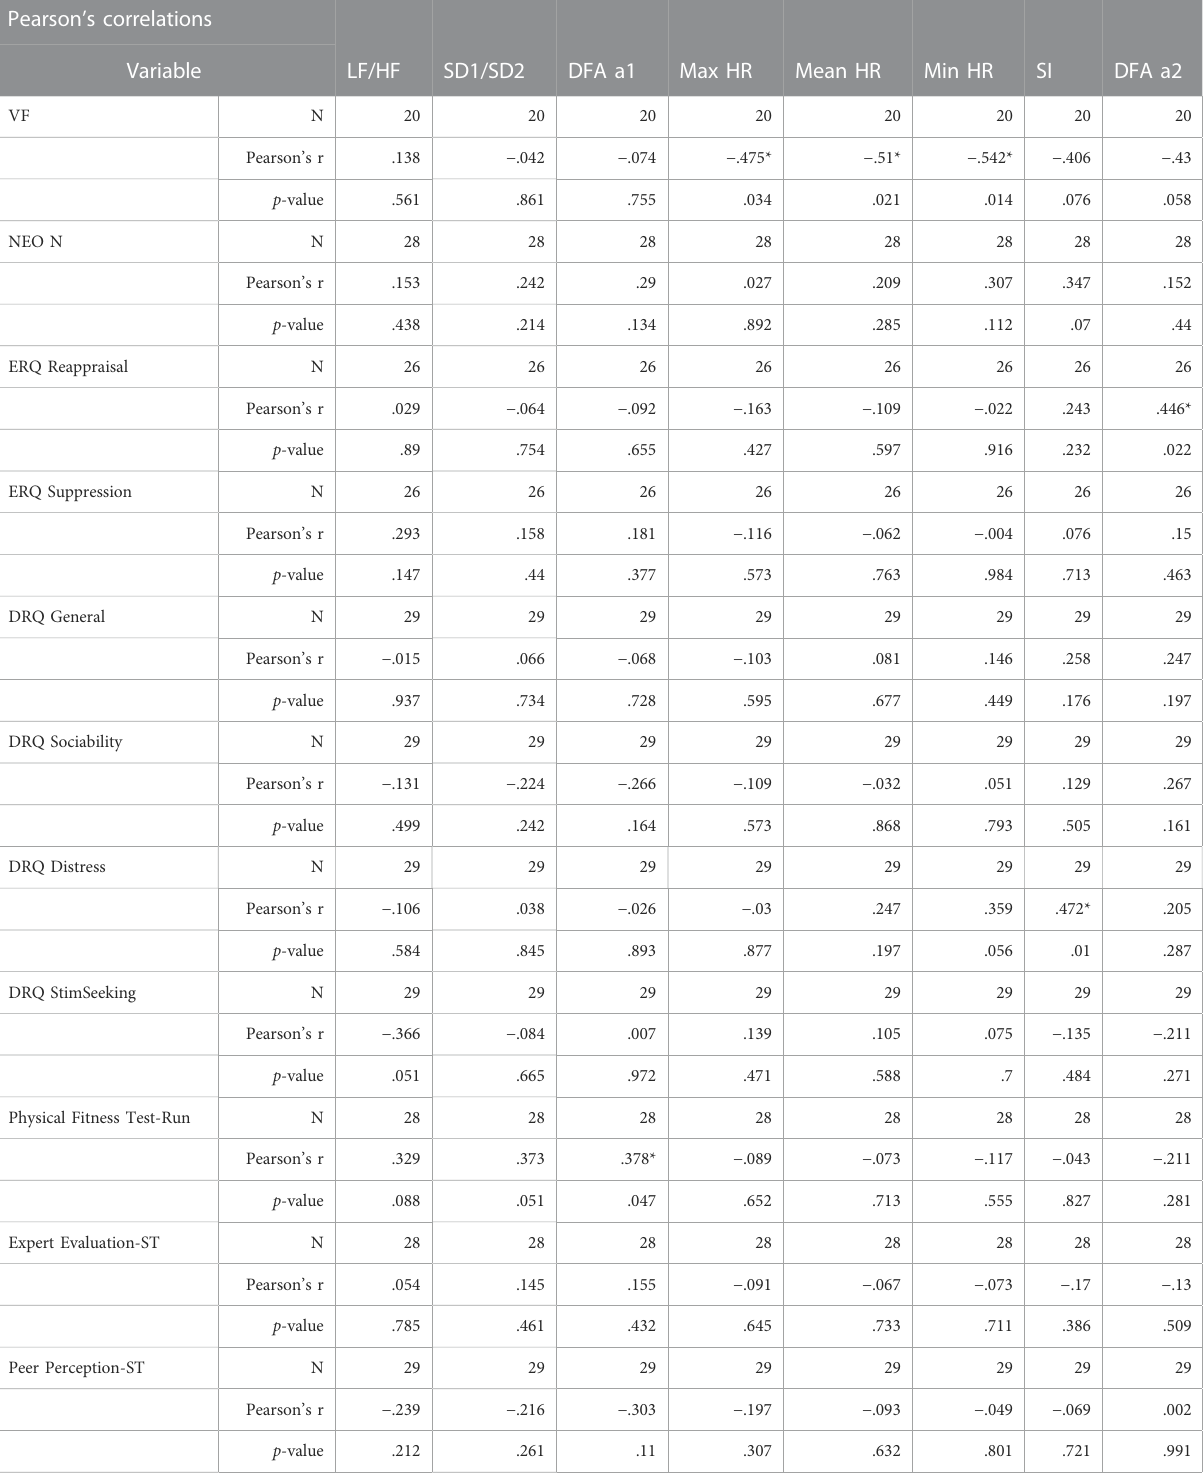
TABLE 3 Correlations between the SNS HR/HRV measures and trait/performance measures. Pearson ’ s